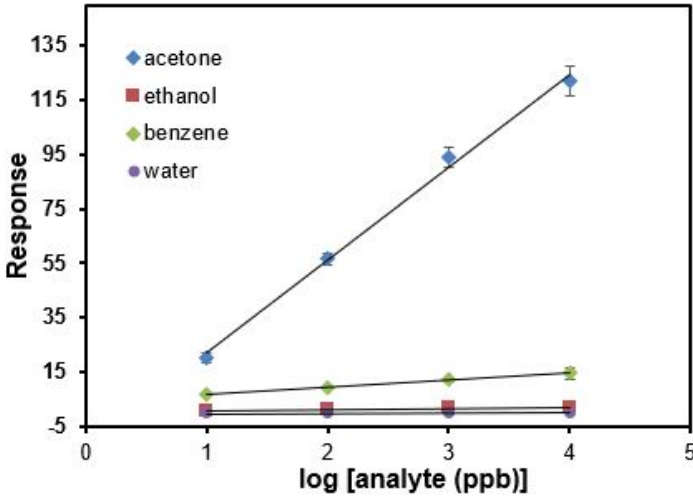
Figure 5. Response of a AuNP sensor derived from t-butyl urea 6.1 vs. log[analyte (ppb)] in the detection of acetone, ethanol and benzene. detection of acetone, ethanol and